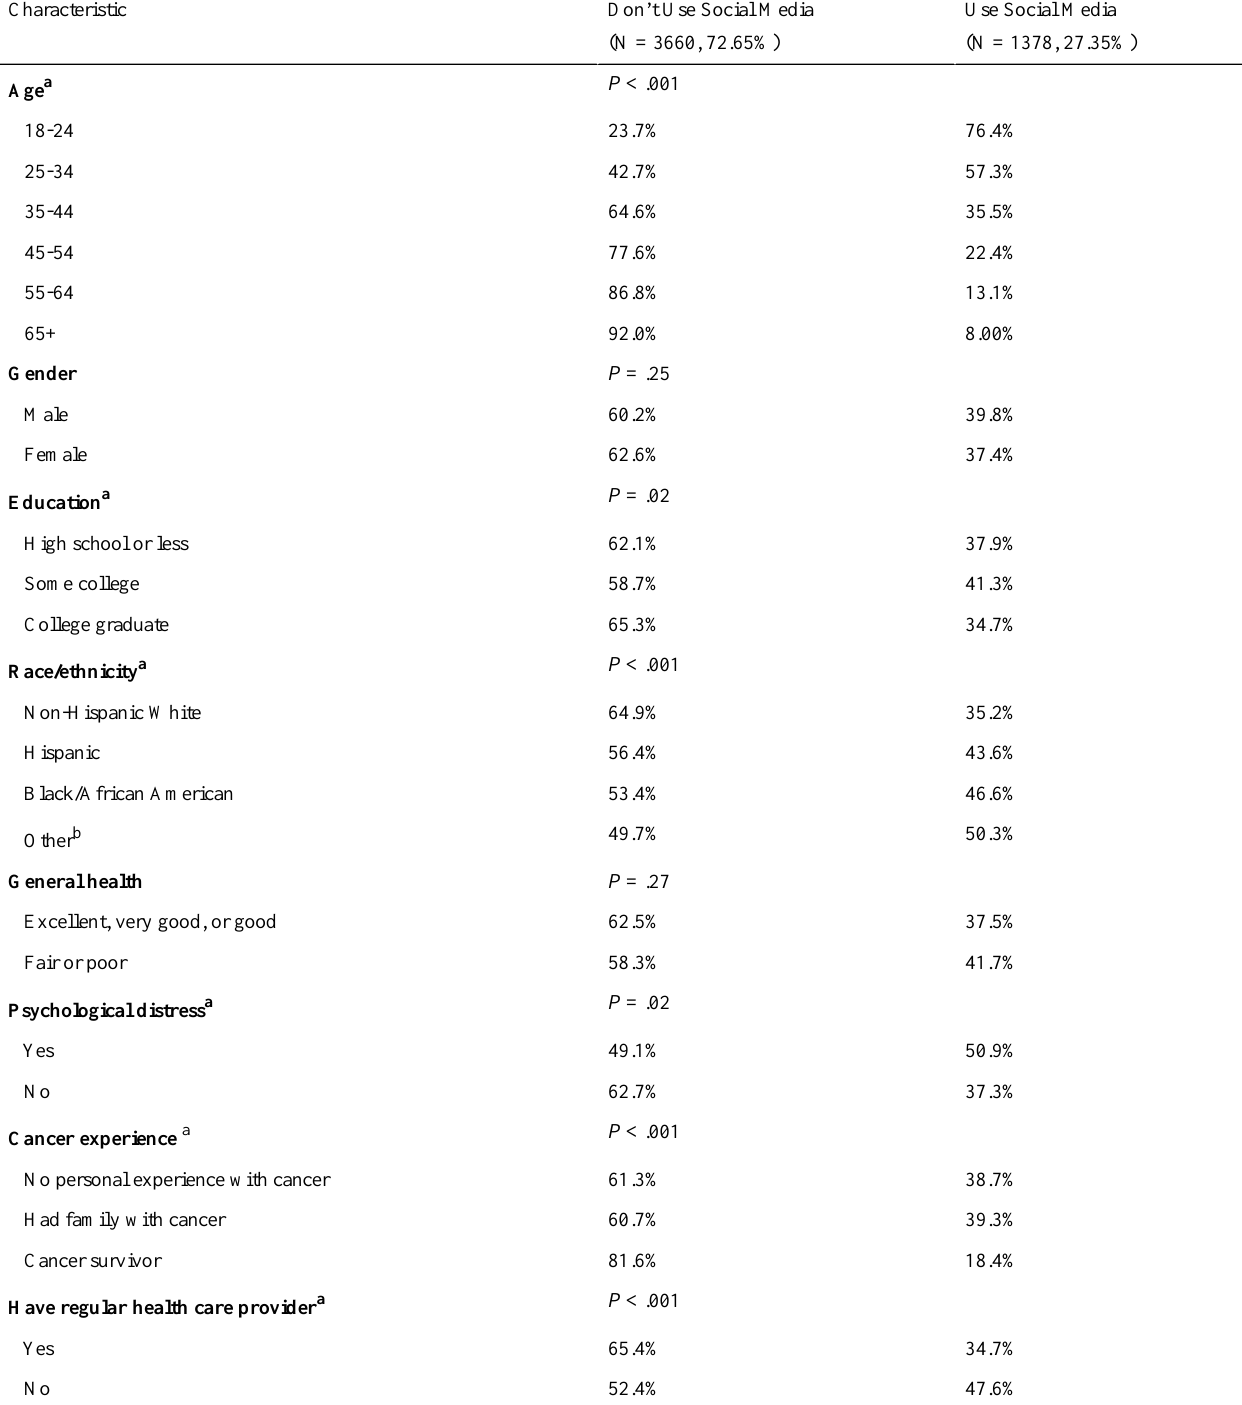
Table 2. Weighted sample characteristics of Internet users (N = 5078, 68.54% of US population) who use and do not use social